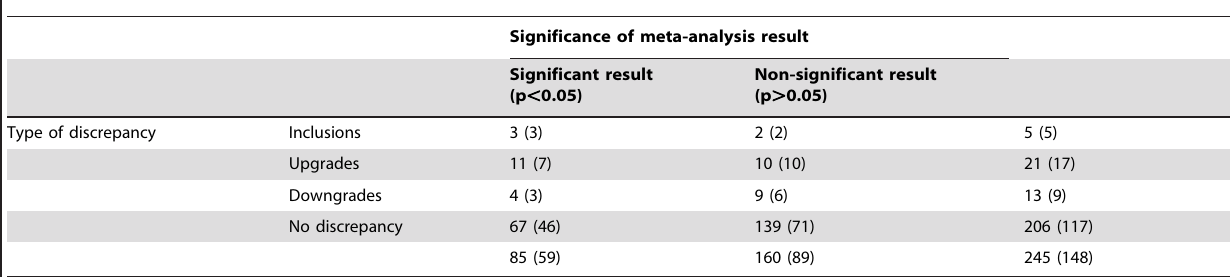
Numbers in parentheses represent the number of reviews affected by each discrepancy. doi:10.1371/journal.pone.0009810.t002 PLoS ONE |